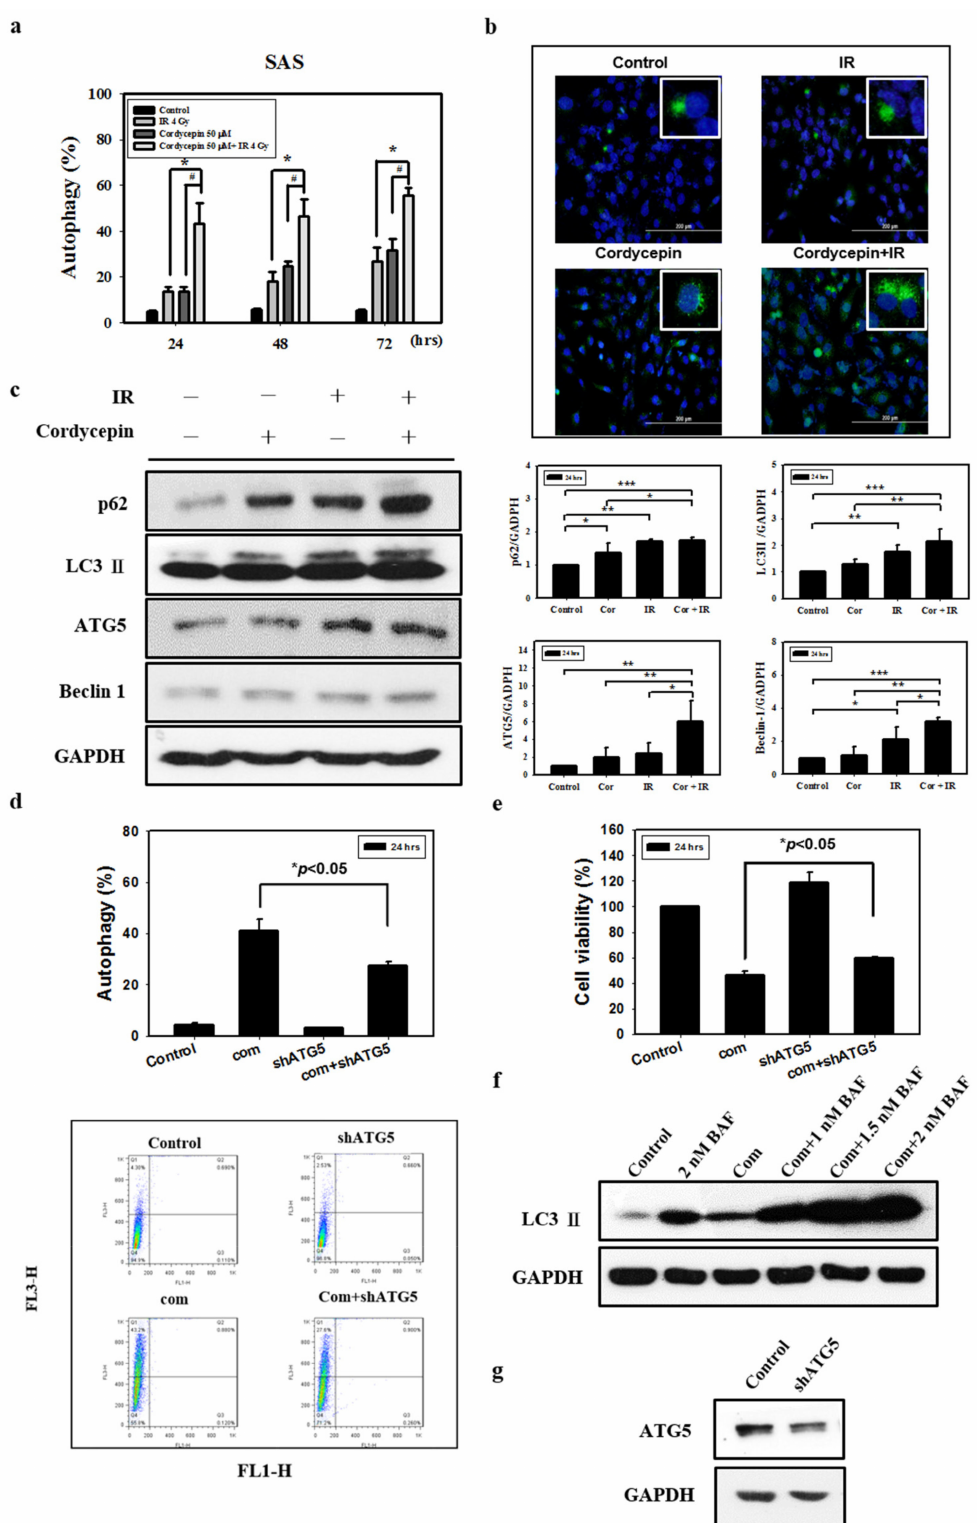
Figure 3. Measurement of autophagy in SAS cells receiving various treatments. Detection of green and red fluorescence in acridine orange-stained cells using flow cytometry. Quantification of acidic vesicular organelles (AVOs) with acridine orange using flow cytometry. ( a ) SAS cells were treated with IR (4 Gy) and cordycepin (50 µ M) alone or their combination for 24, 48, and 72 h. # p < 0.05, cordycepin versus IR + cordycepin. * p < 0.05, IR versus IR + cordycepin. ( b ) Confocal immunofluorescence